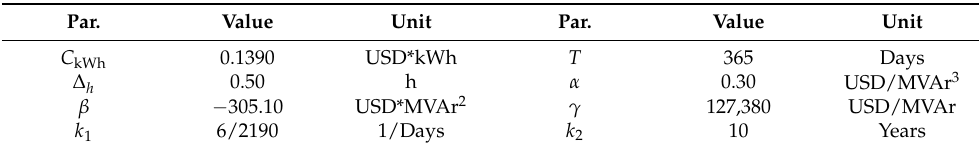
Table 4. Parametric information to evaluate the objective function regarding the investment costs of the